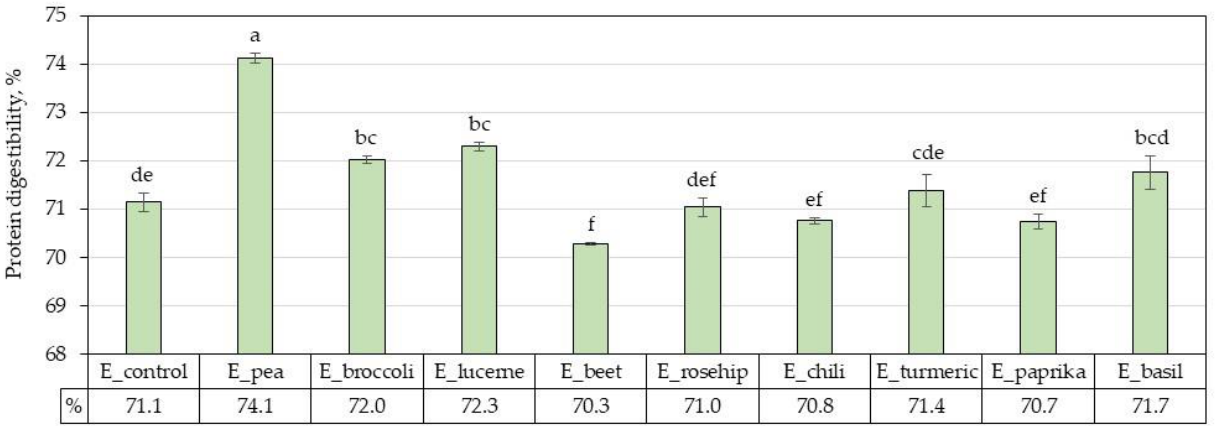
Figure 4. In vitro digestibility of the extrudates. Each bar represents mean values ± standard deviations (n = 3). Different letters indicate significant differences between samples ( p < 0.05).